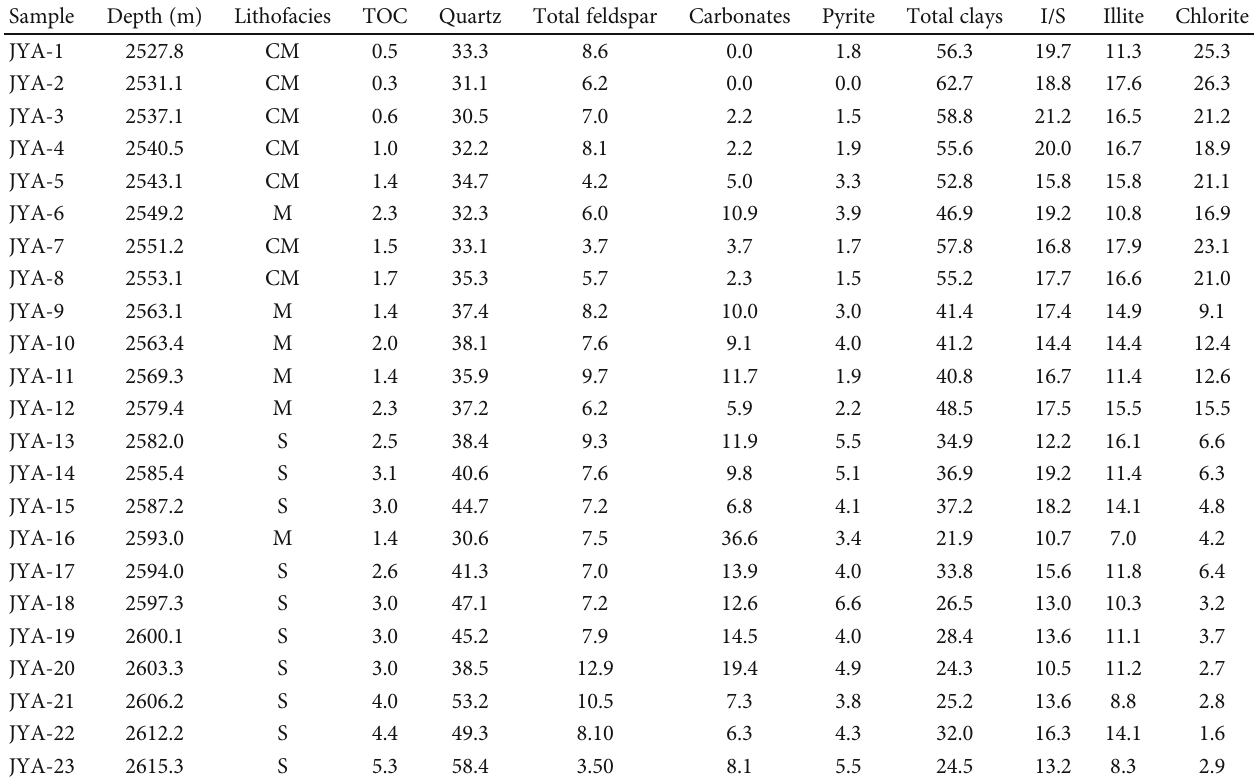
Figure 1: Geological structure of the Sichuan Basin (modi fi ed after [44]). (a) Location of the study area in Sichuan Basin. (b) Tectonic map of the Jiaoshiba area, the top buried depth map of Longmaxi formation, and sampled shale gas well A. Table 1: Lithofacies, TOC, and mineralogy compositions of the Longmaxi shale samples. TOC and mineral content are presented in weight percent (wt